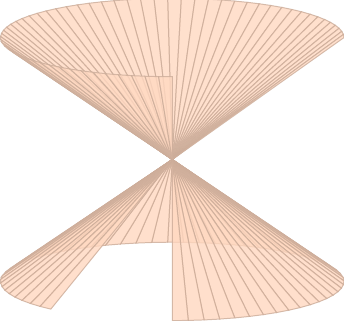
Figure 2. A double napped cone as a surface of revolution of a ray through the origin or R 3